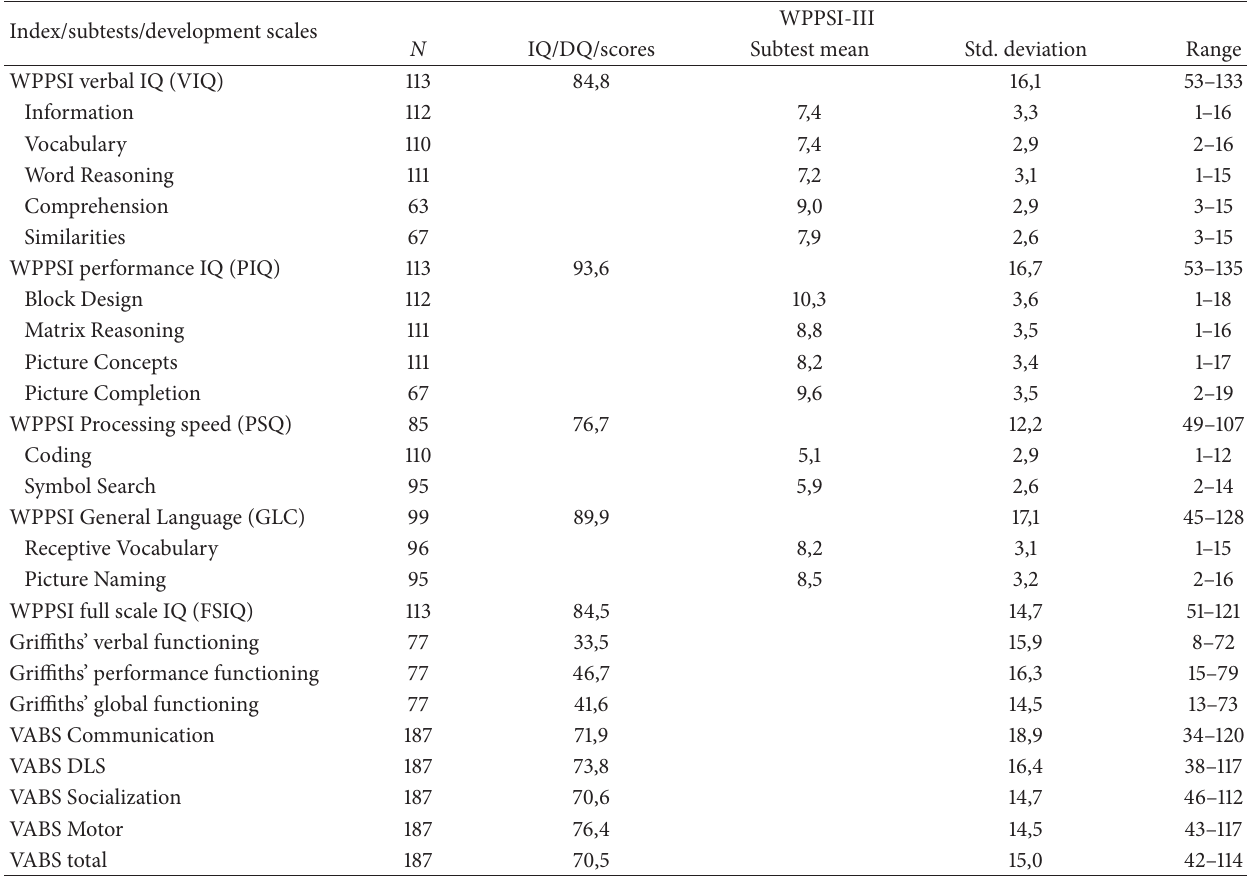
Table 1: Cognitive function measured by WPPSI-III index and subtests results and by Griffiths’ Developmental Scales, Adaptive behavior measured by Vineland Adaptive Behavior